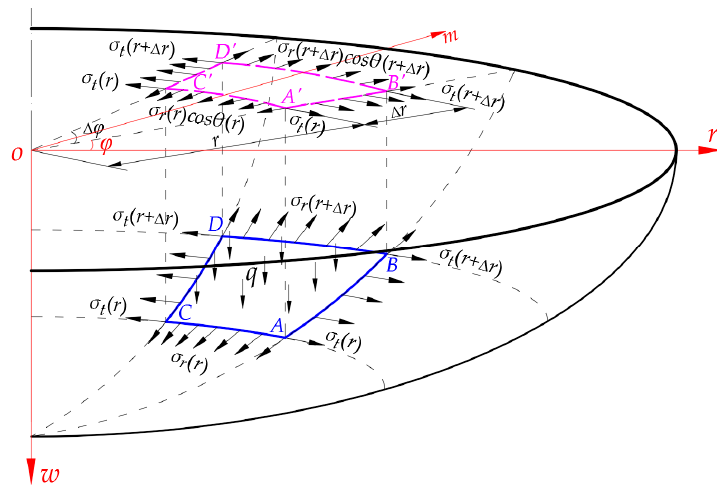
Figure A1. Sketch of the cylindrical coordinate system and the micro element ABCD .